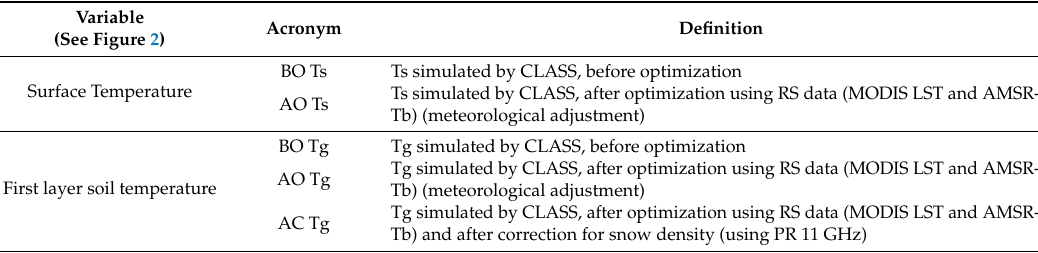
Table 2. Definition of simulated variables used for the analysis.